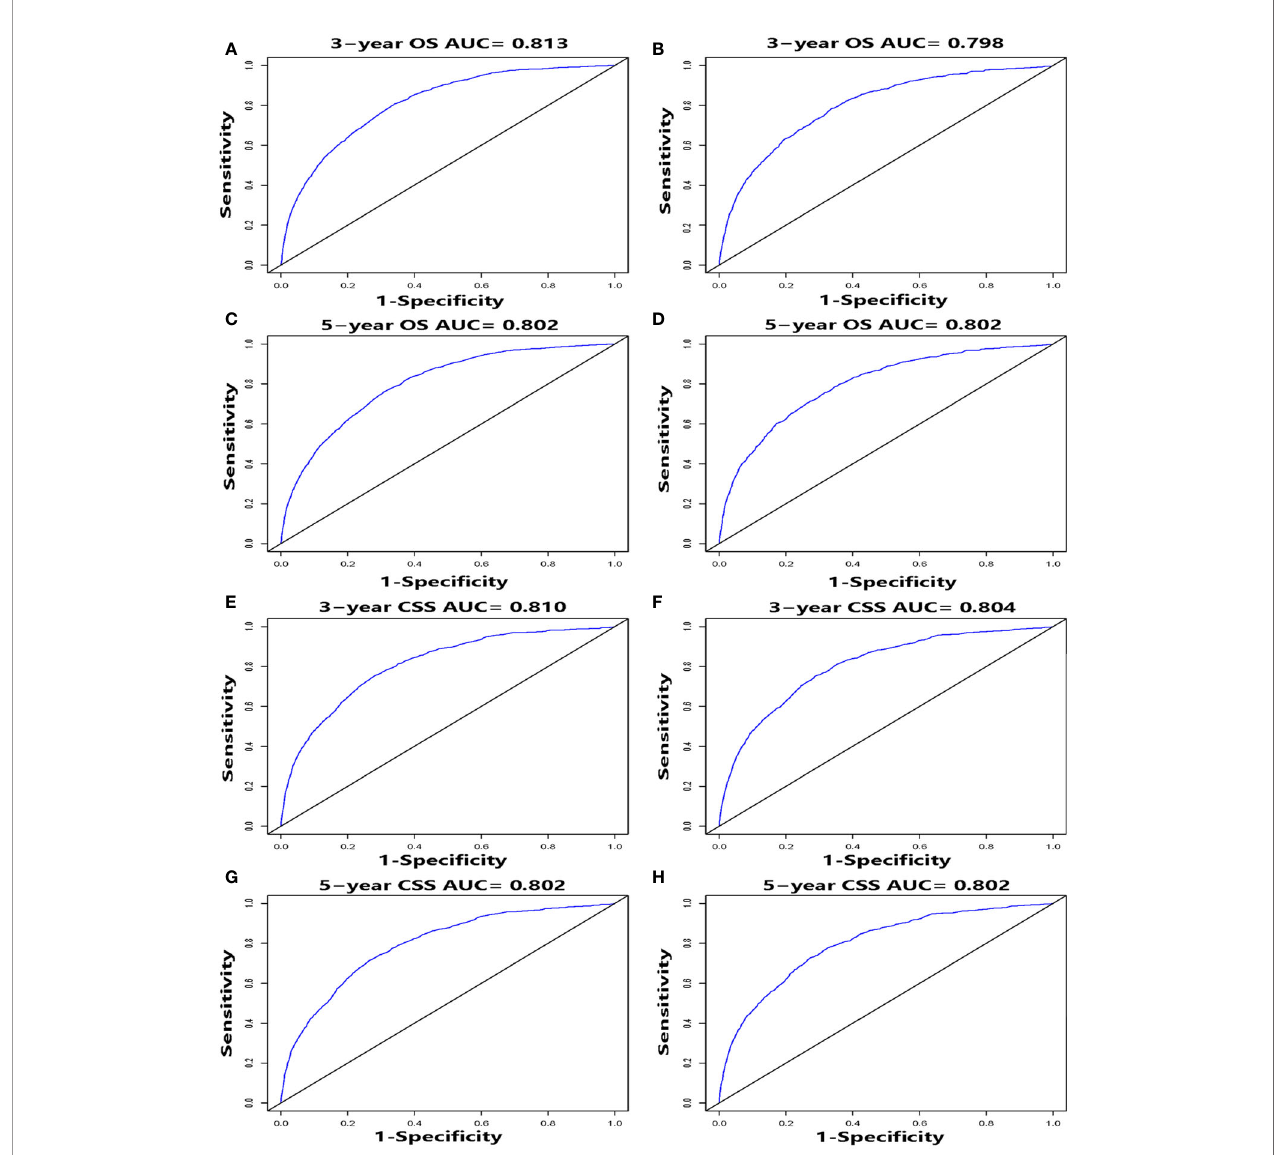
FIGURE 5 | ROC curves, for 3- and 5-year OS and CSS, of the nomograms. ROC curves for 3- and 5-year OS in the training cohort (A, C) and validation cohort (B, D) . ROC curves for 3- and 5-year CSS in the training cohort (E, G) and validation cohort (F, H)